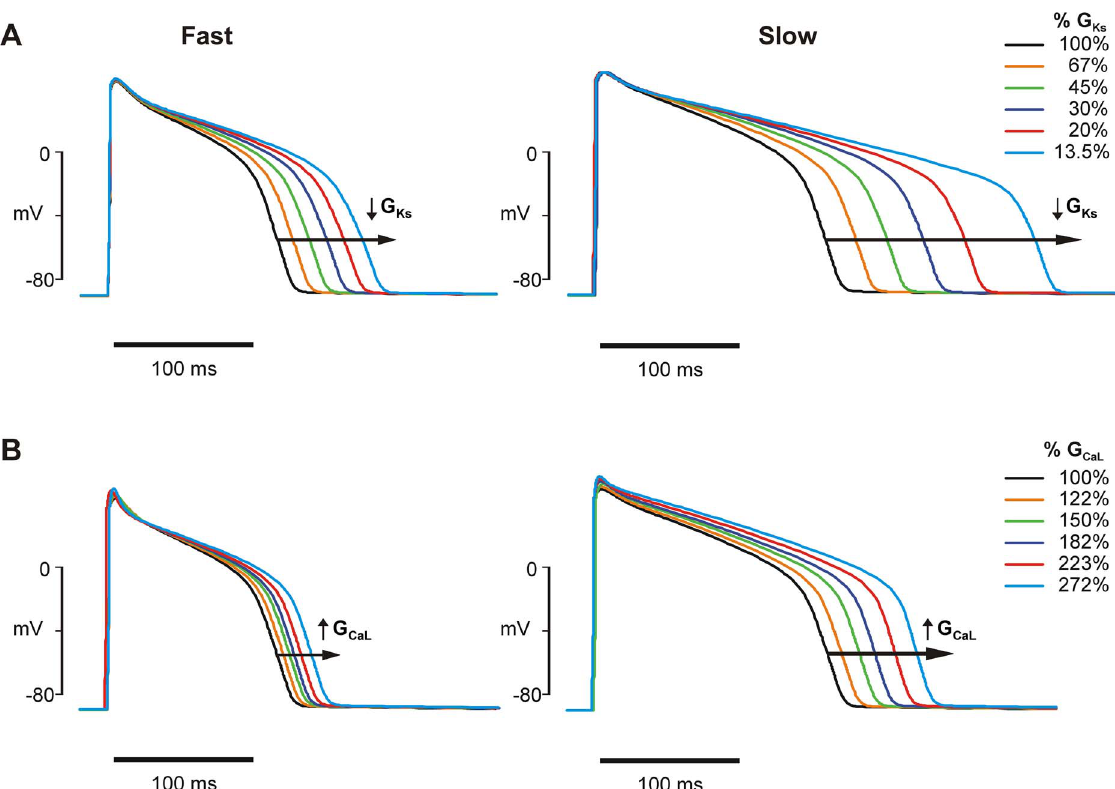
Figure 1. Reverse rate dependence of action potential prolongation. Reverse rate dependence is observed with perturbations to ionic current properties in a ventricular cell model, LR09. ( A ) Slow delayed rectifier K + current (I Ks ) block through decreased maximal conductance (parameter G Ks ) at fast (2 Hz) and slow (0.2 Hz) pacing. ( B ) L-type Ca 2 + current (I CaL ) enhancement through increased channel permeability (parameter G CaL ) at fast (2 Hz) and slow (0.2 Hz) pacing.